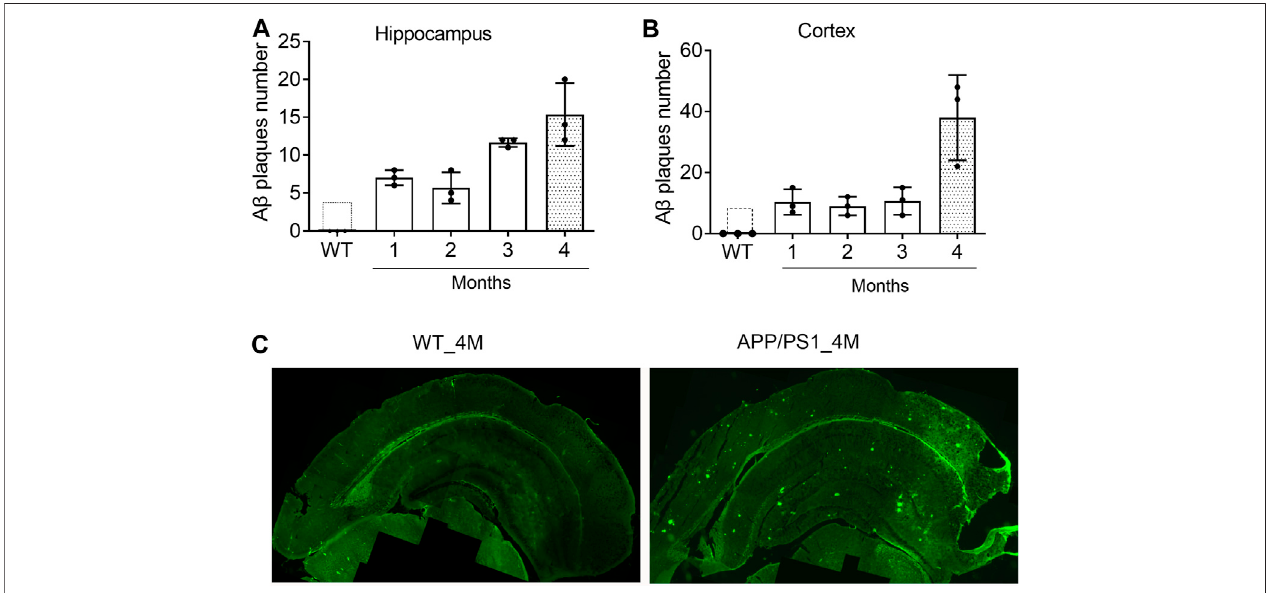
FIGURE 1 | The deposition of A β plaques in the brain of APP/PS1 mice are rapidly increased from the age of 4M (A and B) The changes of A β plaques in the hippocampus and cortex of APP/PS1 mice at the age of 1 – 4M old. WT: wild type mice at the age of 4-months (C) Immuno fl uorescence image shows A β plaques in the brain of 4M-old APP/PS1 and WT